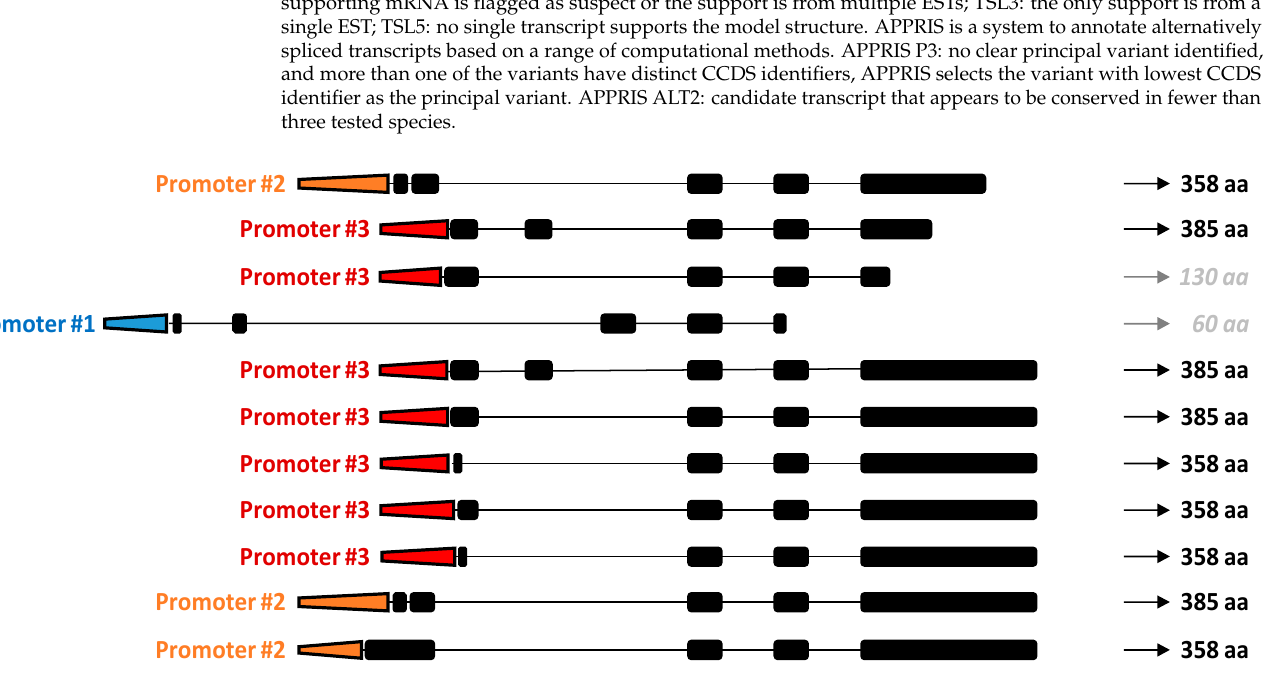
Figure 2. In silico analysis of the human TRIB3 promoter region. The three putative alternative promoters and the related TRIB3 isoforms are indicated (Adapted from [12]). aa: amino acid.